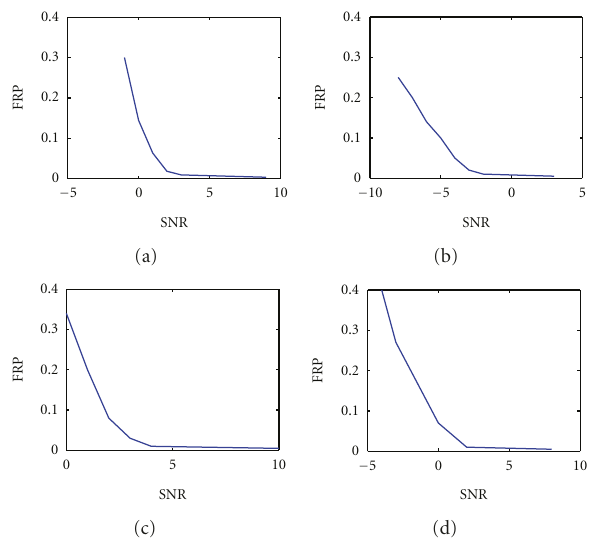
Figure 9: False recognition probability versus SNR. (a) Inter-class recognition (Case I). (b) Inter-class recognition (Case II). (c) Intra- class PSK recognition. (d) Intra-class FSK